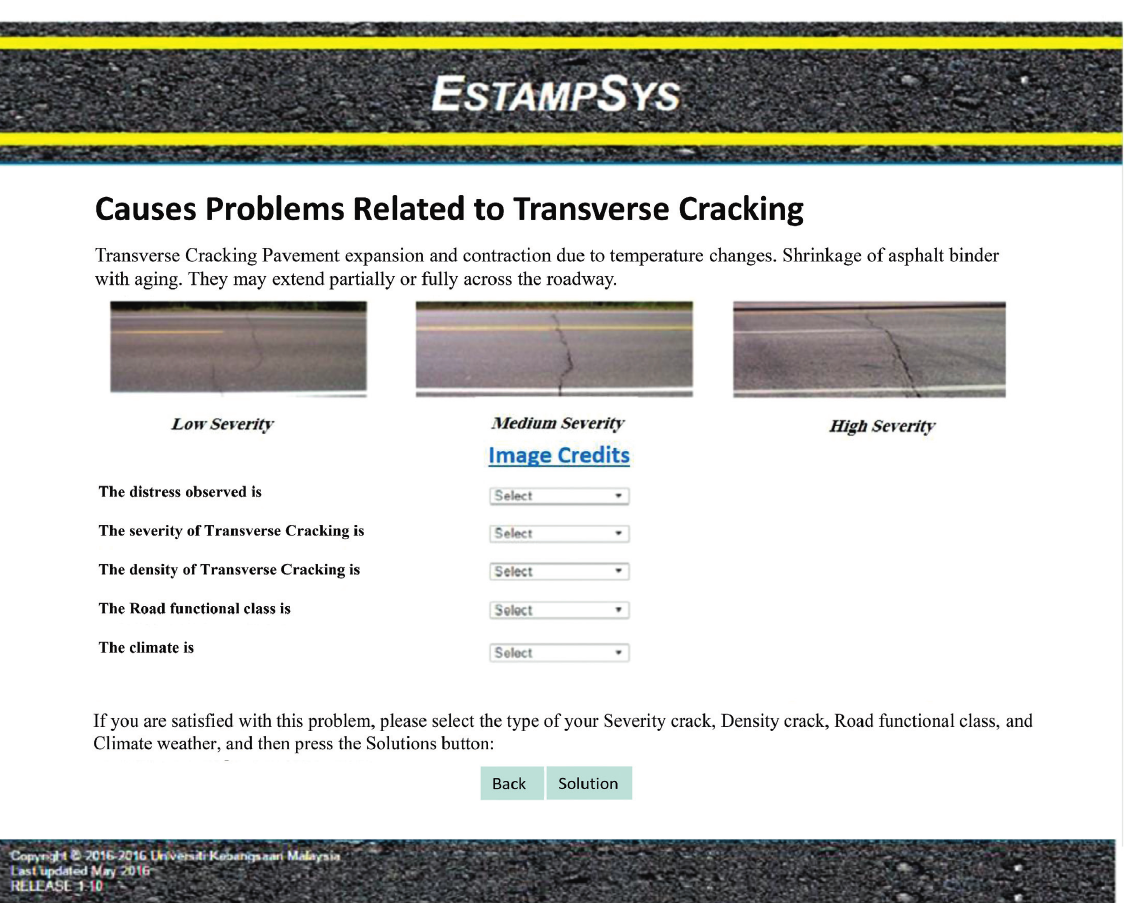
Figure 3: Example of the ESTAMPSYS design inference